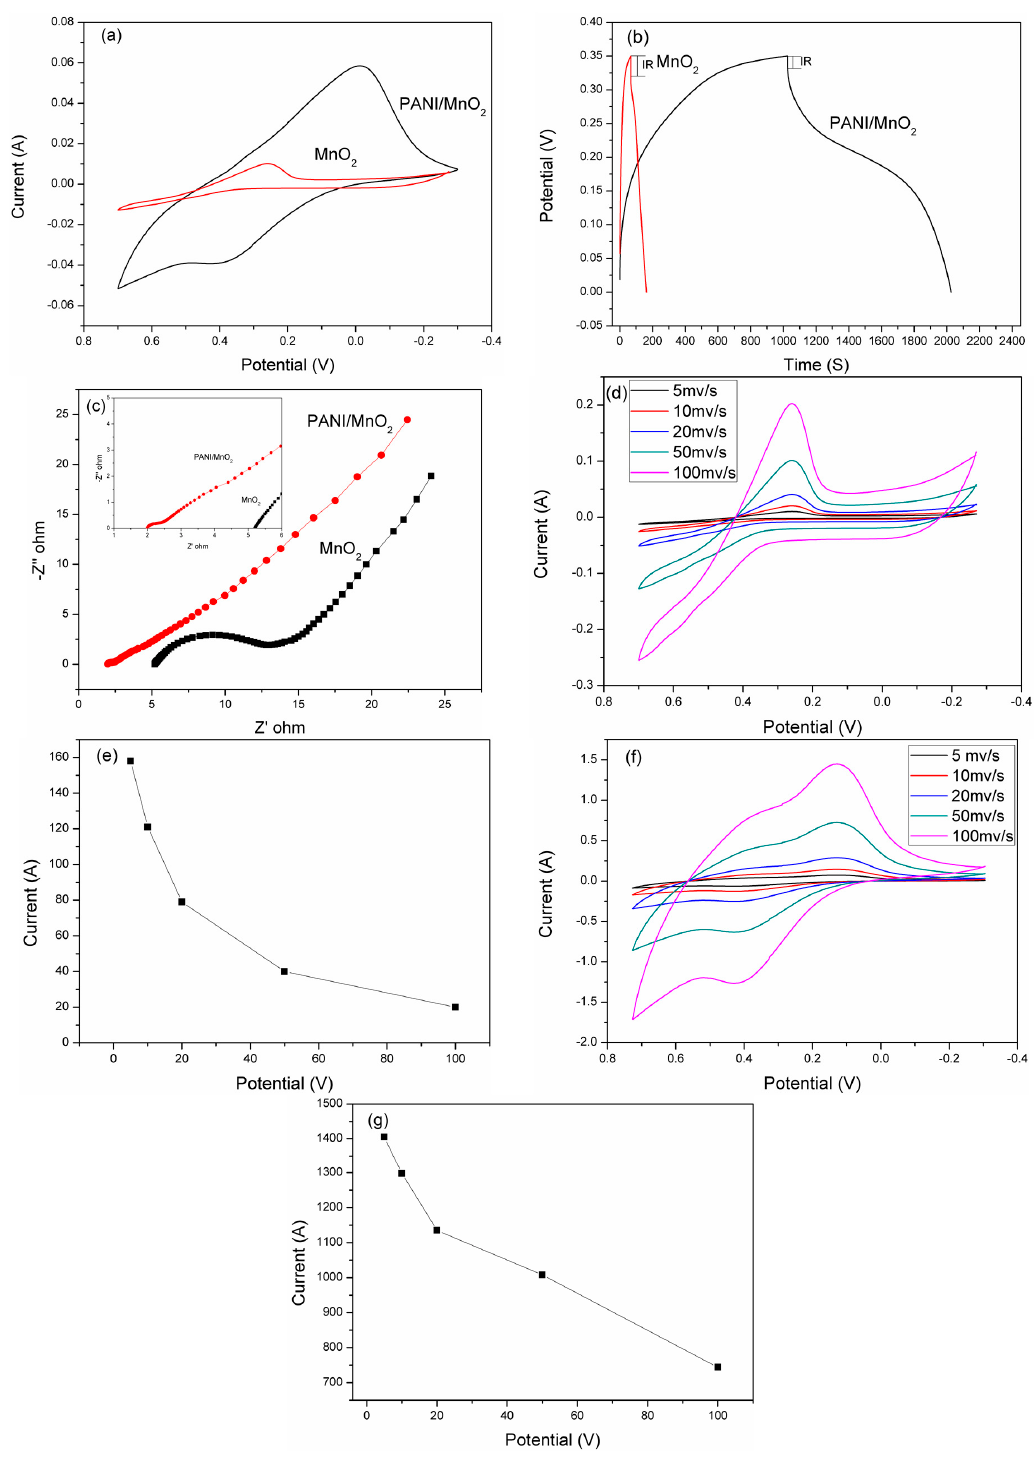
Figure 6. ( a ) CV curves of MnO 2 and PANI/MnO 2 ; ( b ) galvanostatic charge–discharge curve of PANI/MnO 2 ; ( c ) AC impedance curve of MnO 2 and PANI/MnO 2 ; ( d ) CV curves of PANI/MnO 2 at different scan rates in 0.2 M KI–1 M H 2 SO 4 ; ( e ) Specific capacitances of the PANI/MnO 2 at different scan rates; ( f ) CV curves of MnO 2 at different scan rates in 0.2 M KI–1 M H 2 SO 4 ; ( g ) Specific capacitances of the MnO 2 at different scan rates.